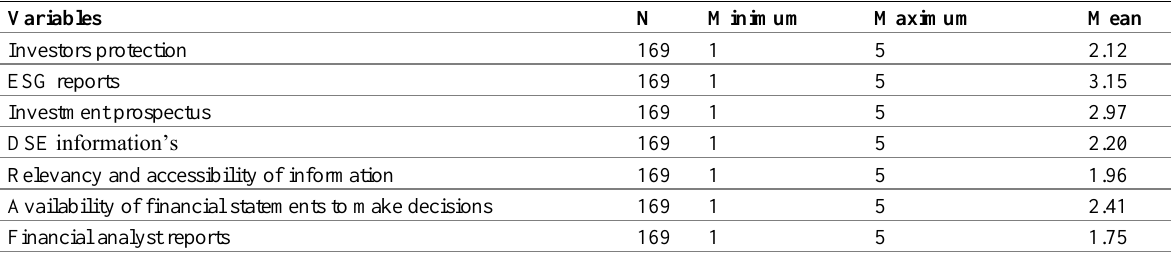
Table 4: The information needed by